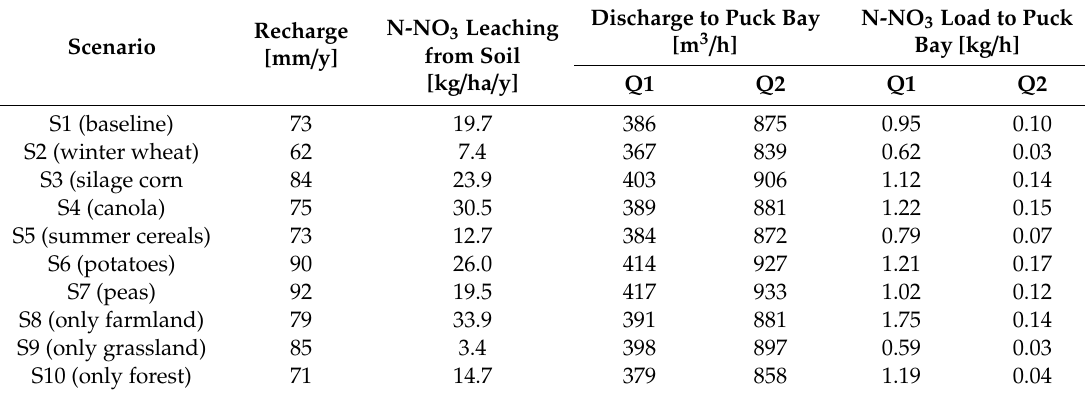
Table 3. Average flow rates and nitrate loads obtained from transient